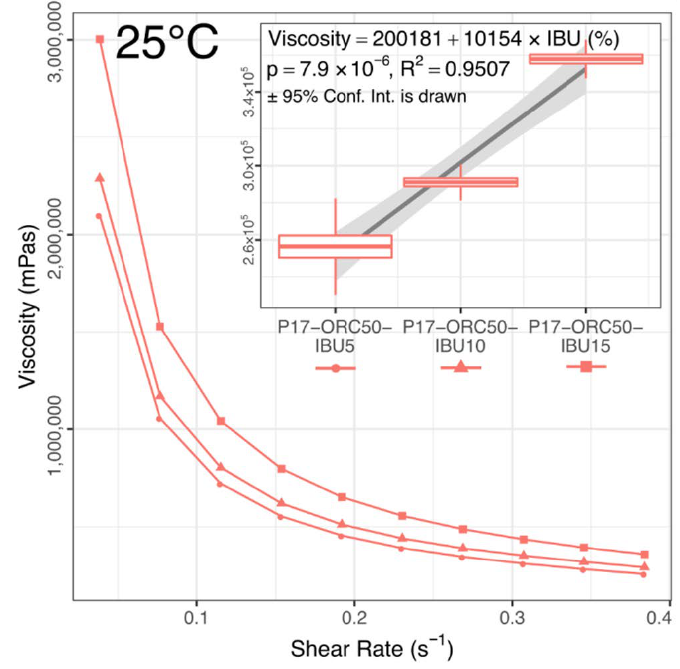
Figure 7. Viscosities vs. shear rate in IBU-loaded emulsions. 25 ◦ C, mean values, n = 3. Inset shows mean viscosities at SR = 0.0384 s − 1 ( ± std error, ± 95% conf. interval) with a quasi-linear correlation between the viscosity and the IBU content. Blank formulations were still liquid at these conditions; thus, they were tested separately, see Figure 6.